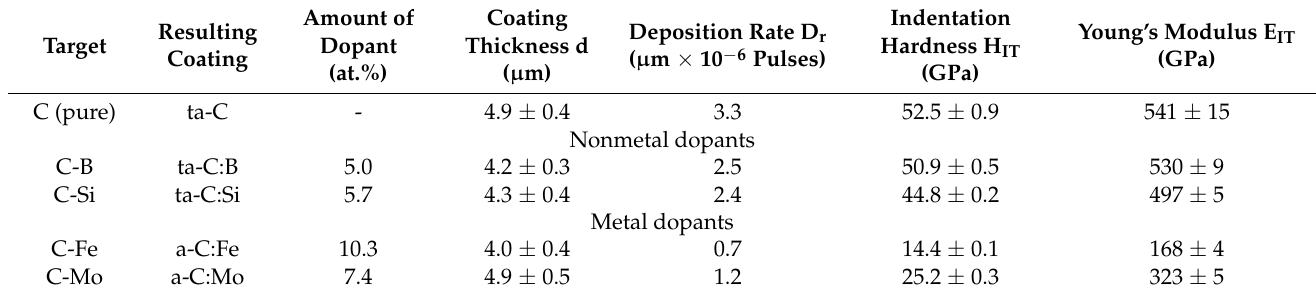
Table 2. Properties of ta-C and (t)a-C:X coatings, mounted on sample position P1; summary from